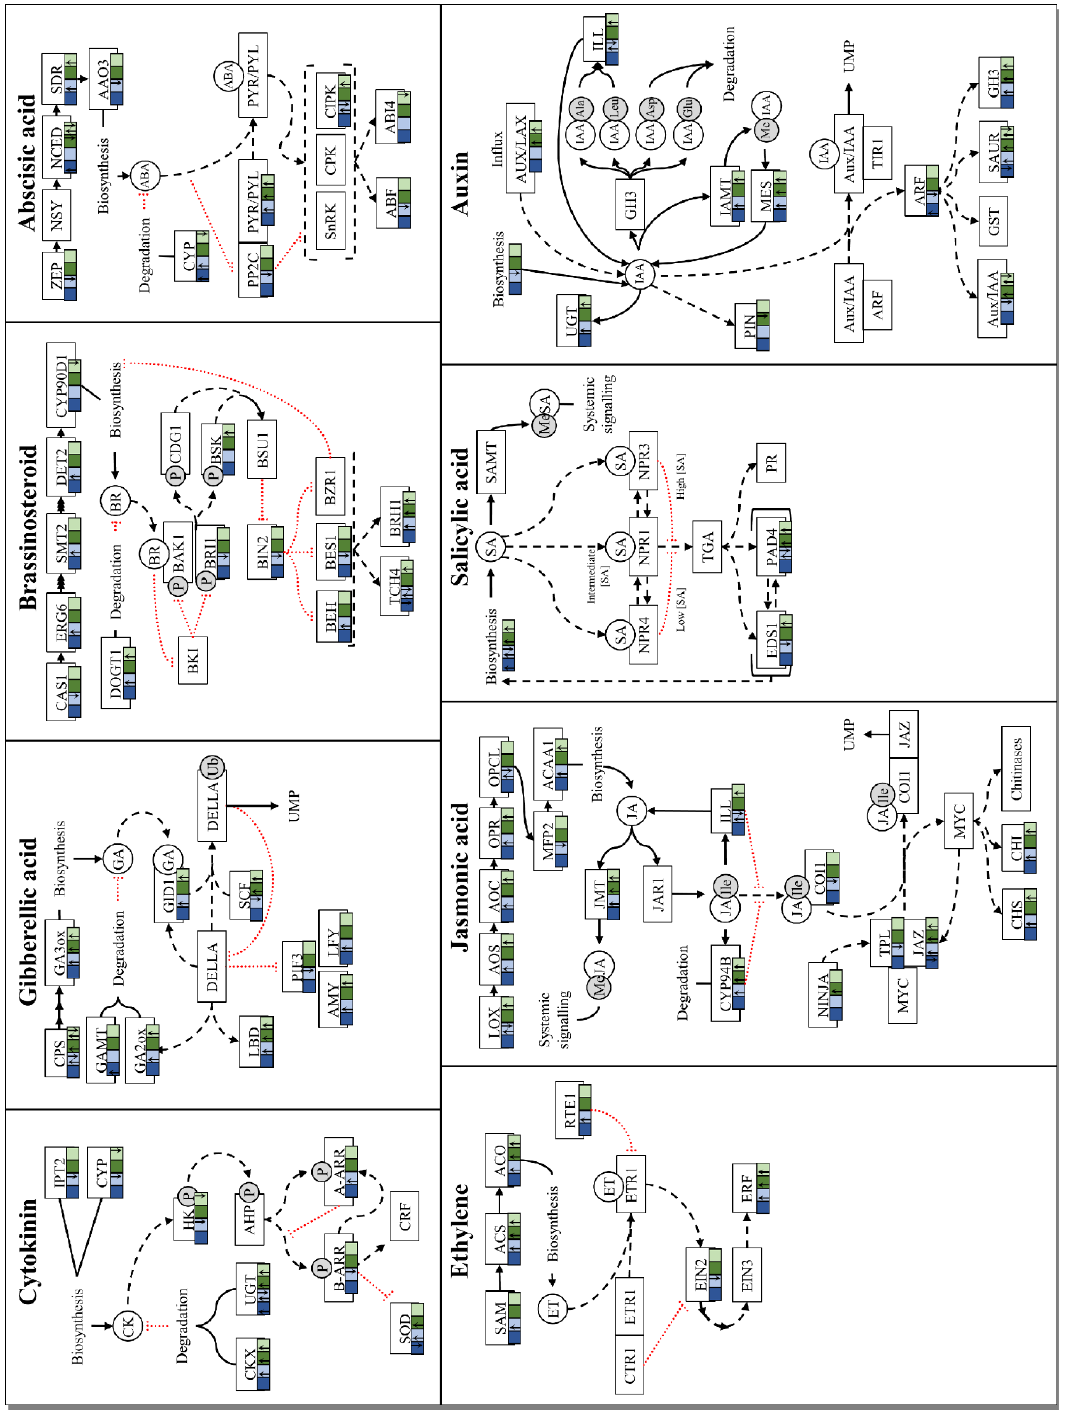
Figure 2. Summary of phytohormone related host DEGs during F. circinatum challenge. Up- and down-regulation (inoculated relative to mock-inoculated) of genes related to cytokinin, abscisic acid, gibberellic acid, brassinosteroid, ethylene, jasmonic acid, salicylic acid and auxin signalling, in P. patula (blue) and P. tecunumanii (green) at three (dark colours) and seven (light colours) days post inoculation, are indicated by arrows ( ↑ and ↓ respectively; Additional file 5: Table S4 & S5). Dotted red lines indicate suppression, dashed black lines indicate positive interaction, solid black lines